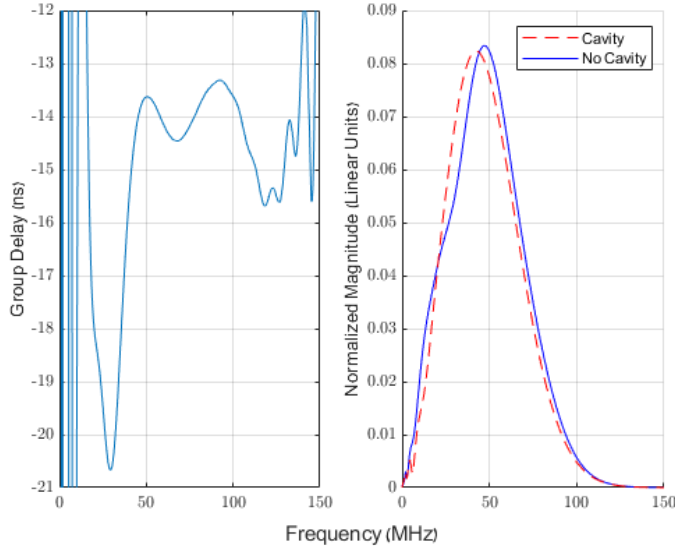
Figure 5. The group delay contributed by propagation through a cavity, found using simulated measurements, and the magnitude spectra of the two signals. The cavity and soil were identical to those used in Figure 4, other than that the height of the cavity was limited to two meters, thus allowing the wave to diffract around the cavity. Note the slight change in scale from Figure